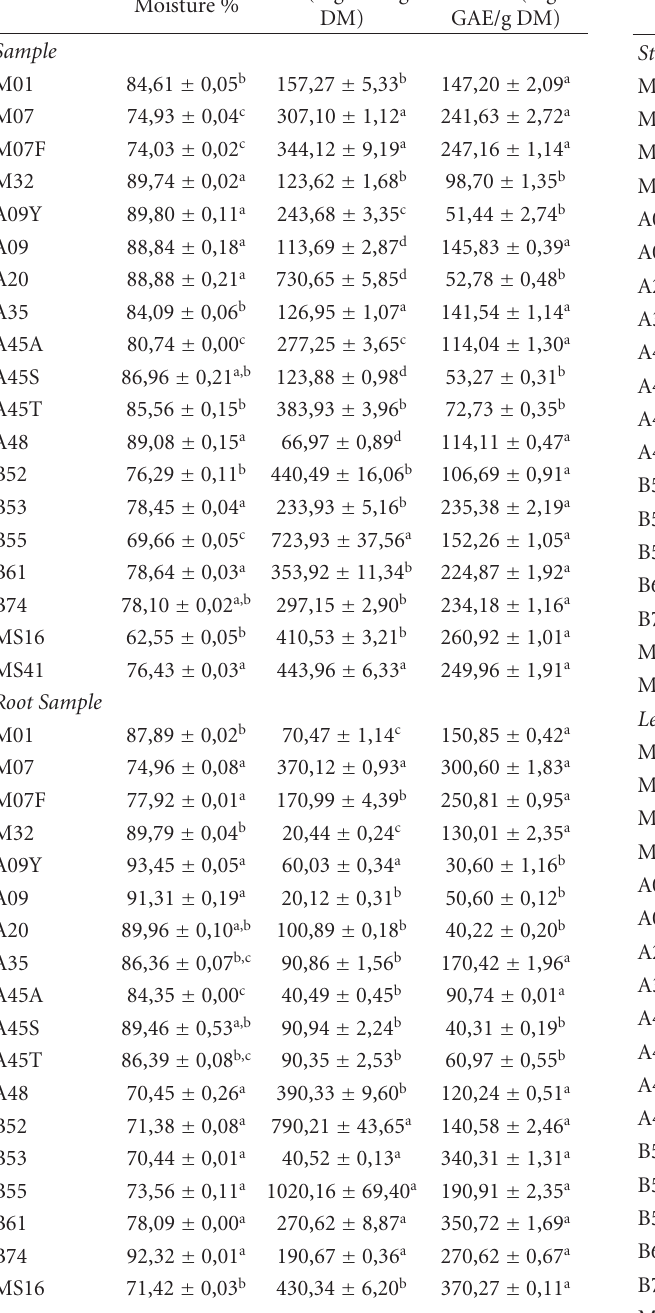
Table 1: Moisture content, total phenolic content, and total anti- oxidant activity of total and root of fresh nettle.